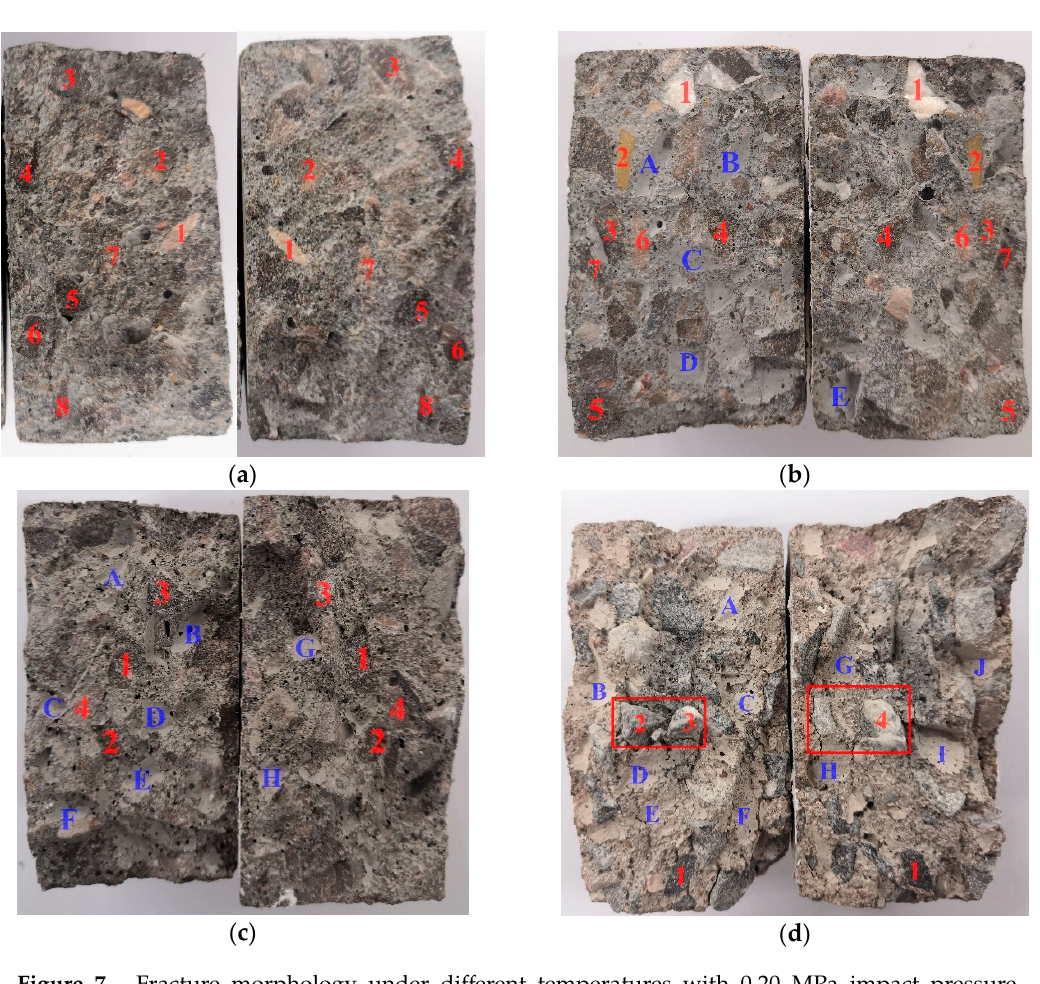
Figure 7. Fracture morphology under different temperatures with 0.20 MPa impact pressure (aggregate particles marked by the same number on fracture surfaces of the left and right halves are fragments of the same initial particle), ( a ) 25 °C, ( b ) 200 °C, ( c ) 400 °C, ( d ) 600 °C.